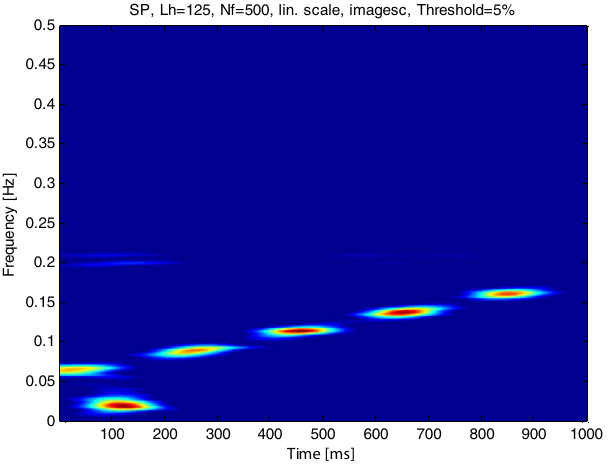
Figure 10. The time–frequency diagram of every